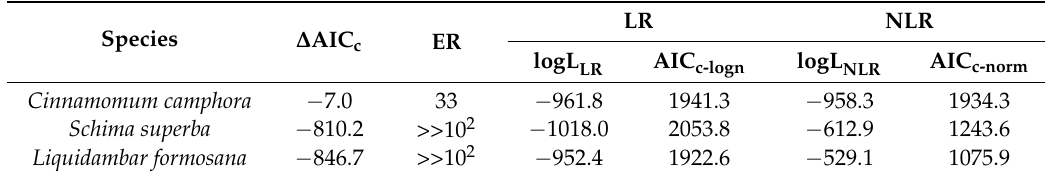
Table 3. Results of likelihood analysis based on the joint likelihood function for additive system of three tree species.